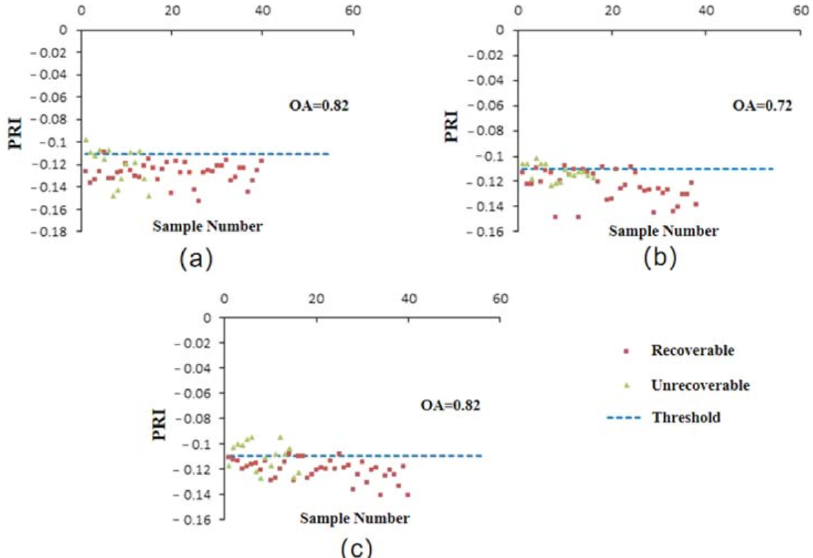
Figure 8. Differentiation between recoverable and unrecoverable corn plants based on PRI at 1 WAT ( a ), 2 WAT, ( b ) and 3 WAT ( c